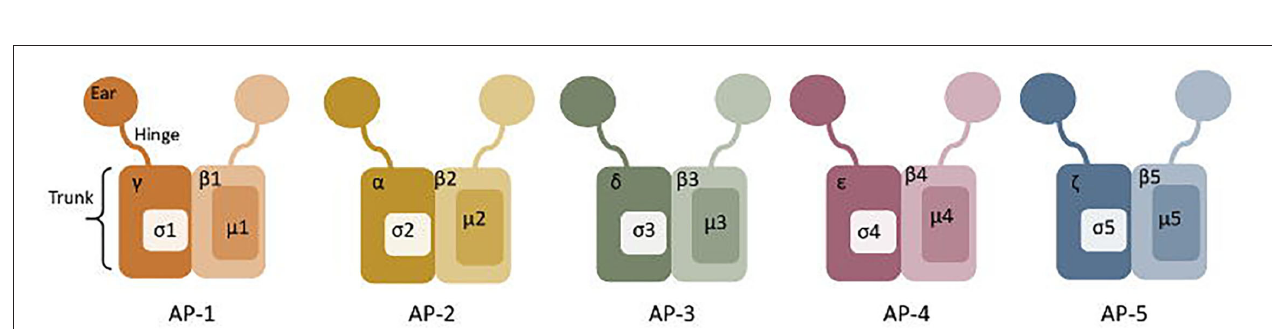
FIGURE 5 | Structure of Adaptor complexes (AP) 1-5. The hinge, truck and ear regions are labelled on AP-1, and the subunits are labelled on each adaptor